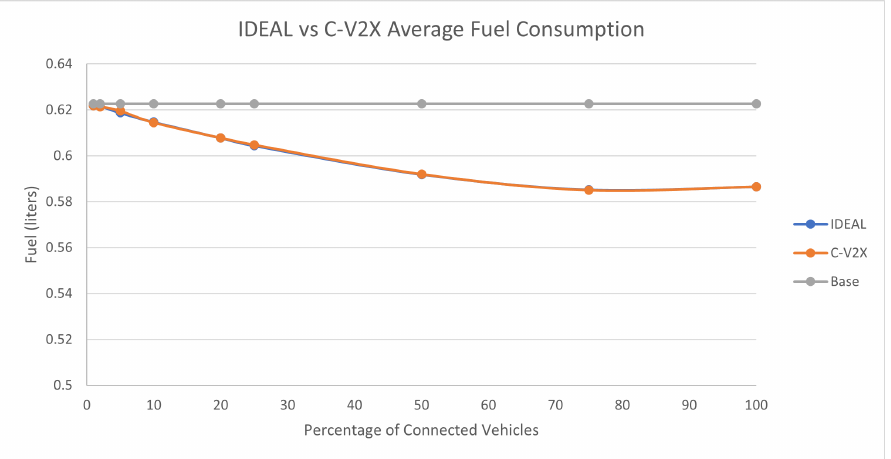
Figure 10. Average network-wide Fuel consumption of Energy-Efficient dynamic routing application using IDEAL and C-V2X communication on LA road network with traffic demand of scale factor 0.5.